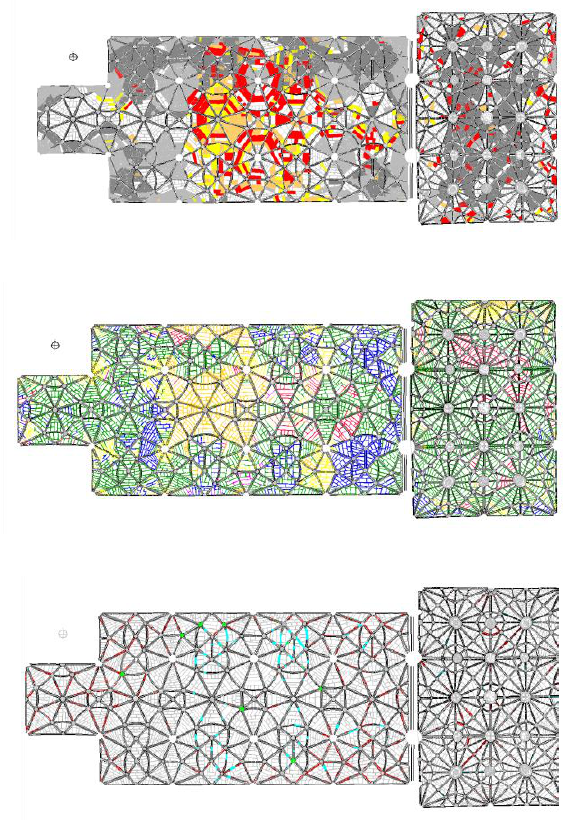
Figure 6. Mapping of the materials and anomalies of the nave vault of Jerónimos monastery: colours of the stones (a) and the joint mortars (b), and pathology of the ribs (c) (Genin, 1999).